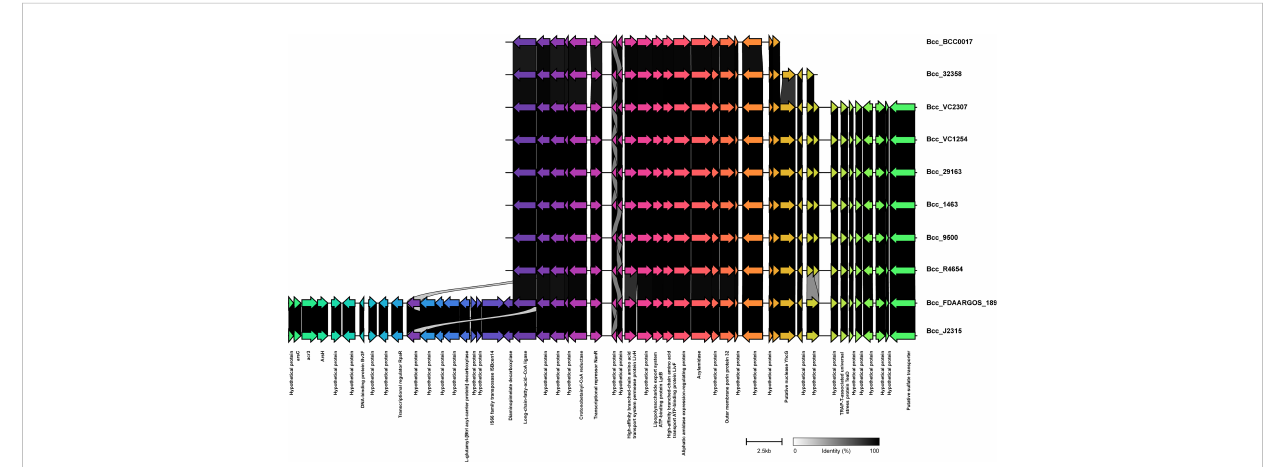
FIGURE 6 Comparison of pathogenicity island GI11 between CC31 isolates across clades. Genes are represented by arrowed boxes with labels. Percent identity is represented by connecting links between